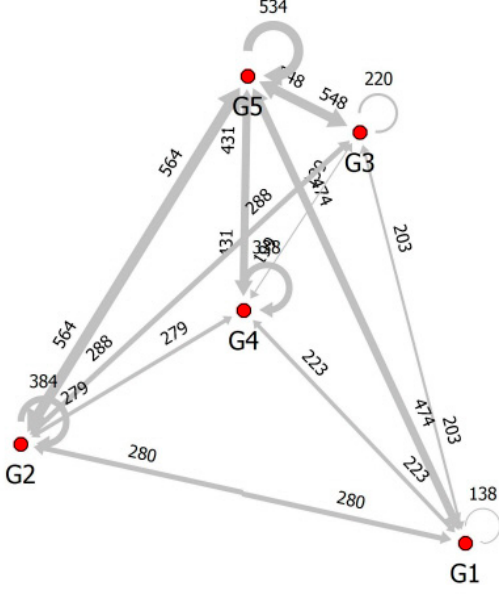
Figure 8. Group network ‐ Two mode network.